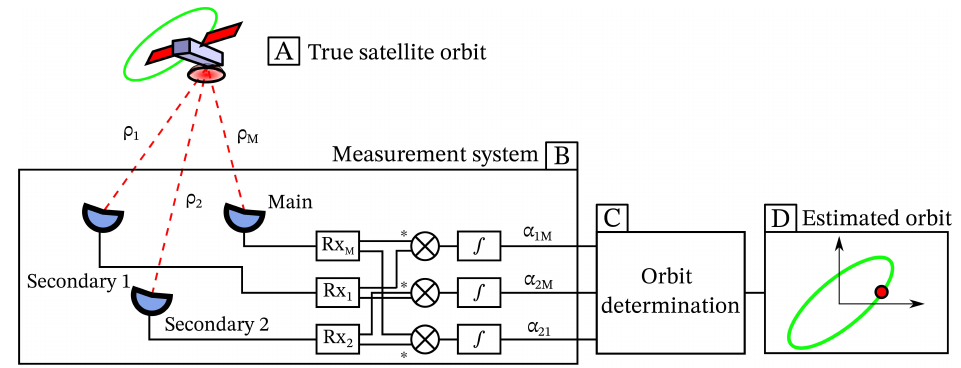
Figure 2. Interferometric orbit retrieval block diagram. The system correlates the satellite signal received by different antenna sites at different locations. The resulting interferometric phase α ij is used as the input observable in the orbit determination module, which is based on the combination of a GEO dynamical model, which simulates the trajectory of the satellite, and an interferometric measurement model, which simulates the acquired phases. The estimated trajectory corresponds to the best fit between the experimental measurements and the modeled